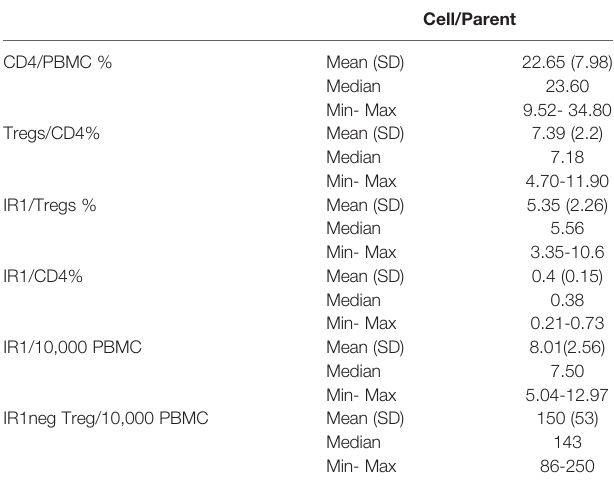
TABLE 1 | Relative cell frequencies. Healthy Donors (n=17).